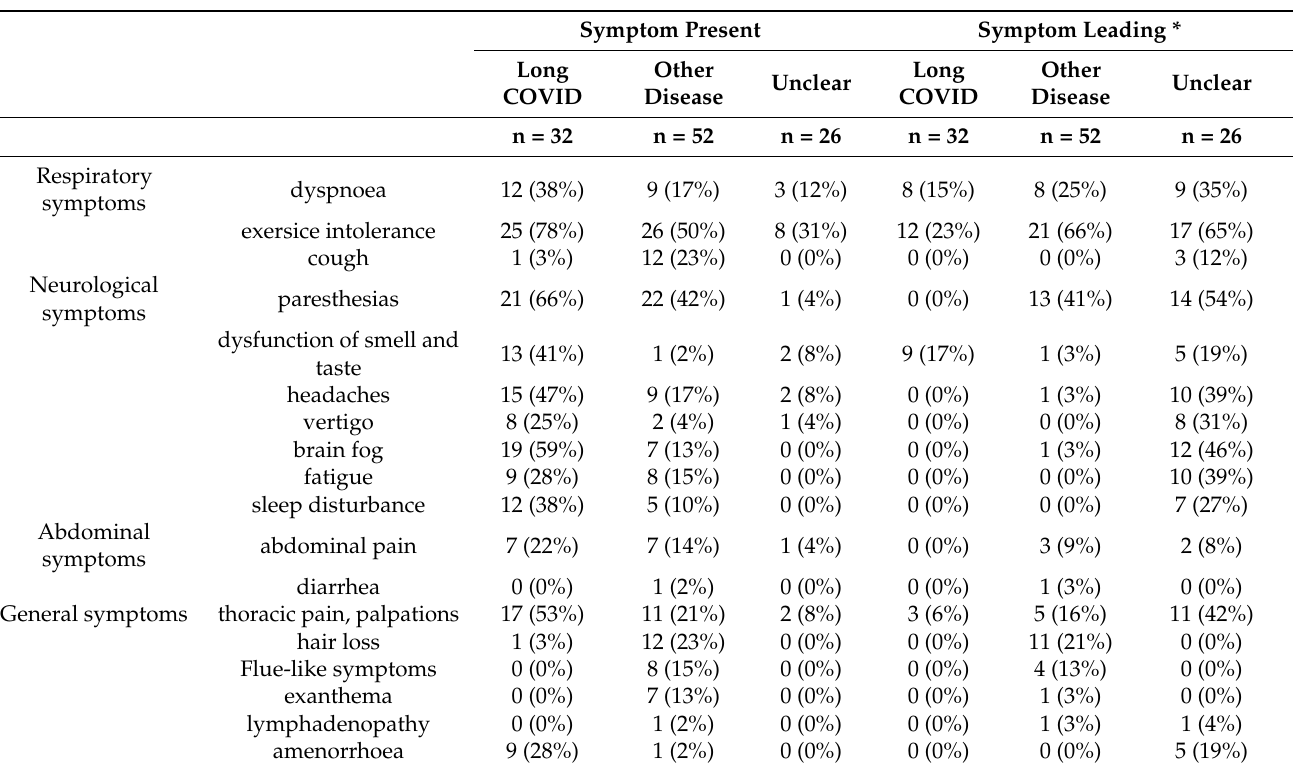
Table 2. Symptoms at